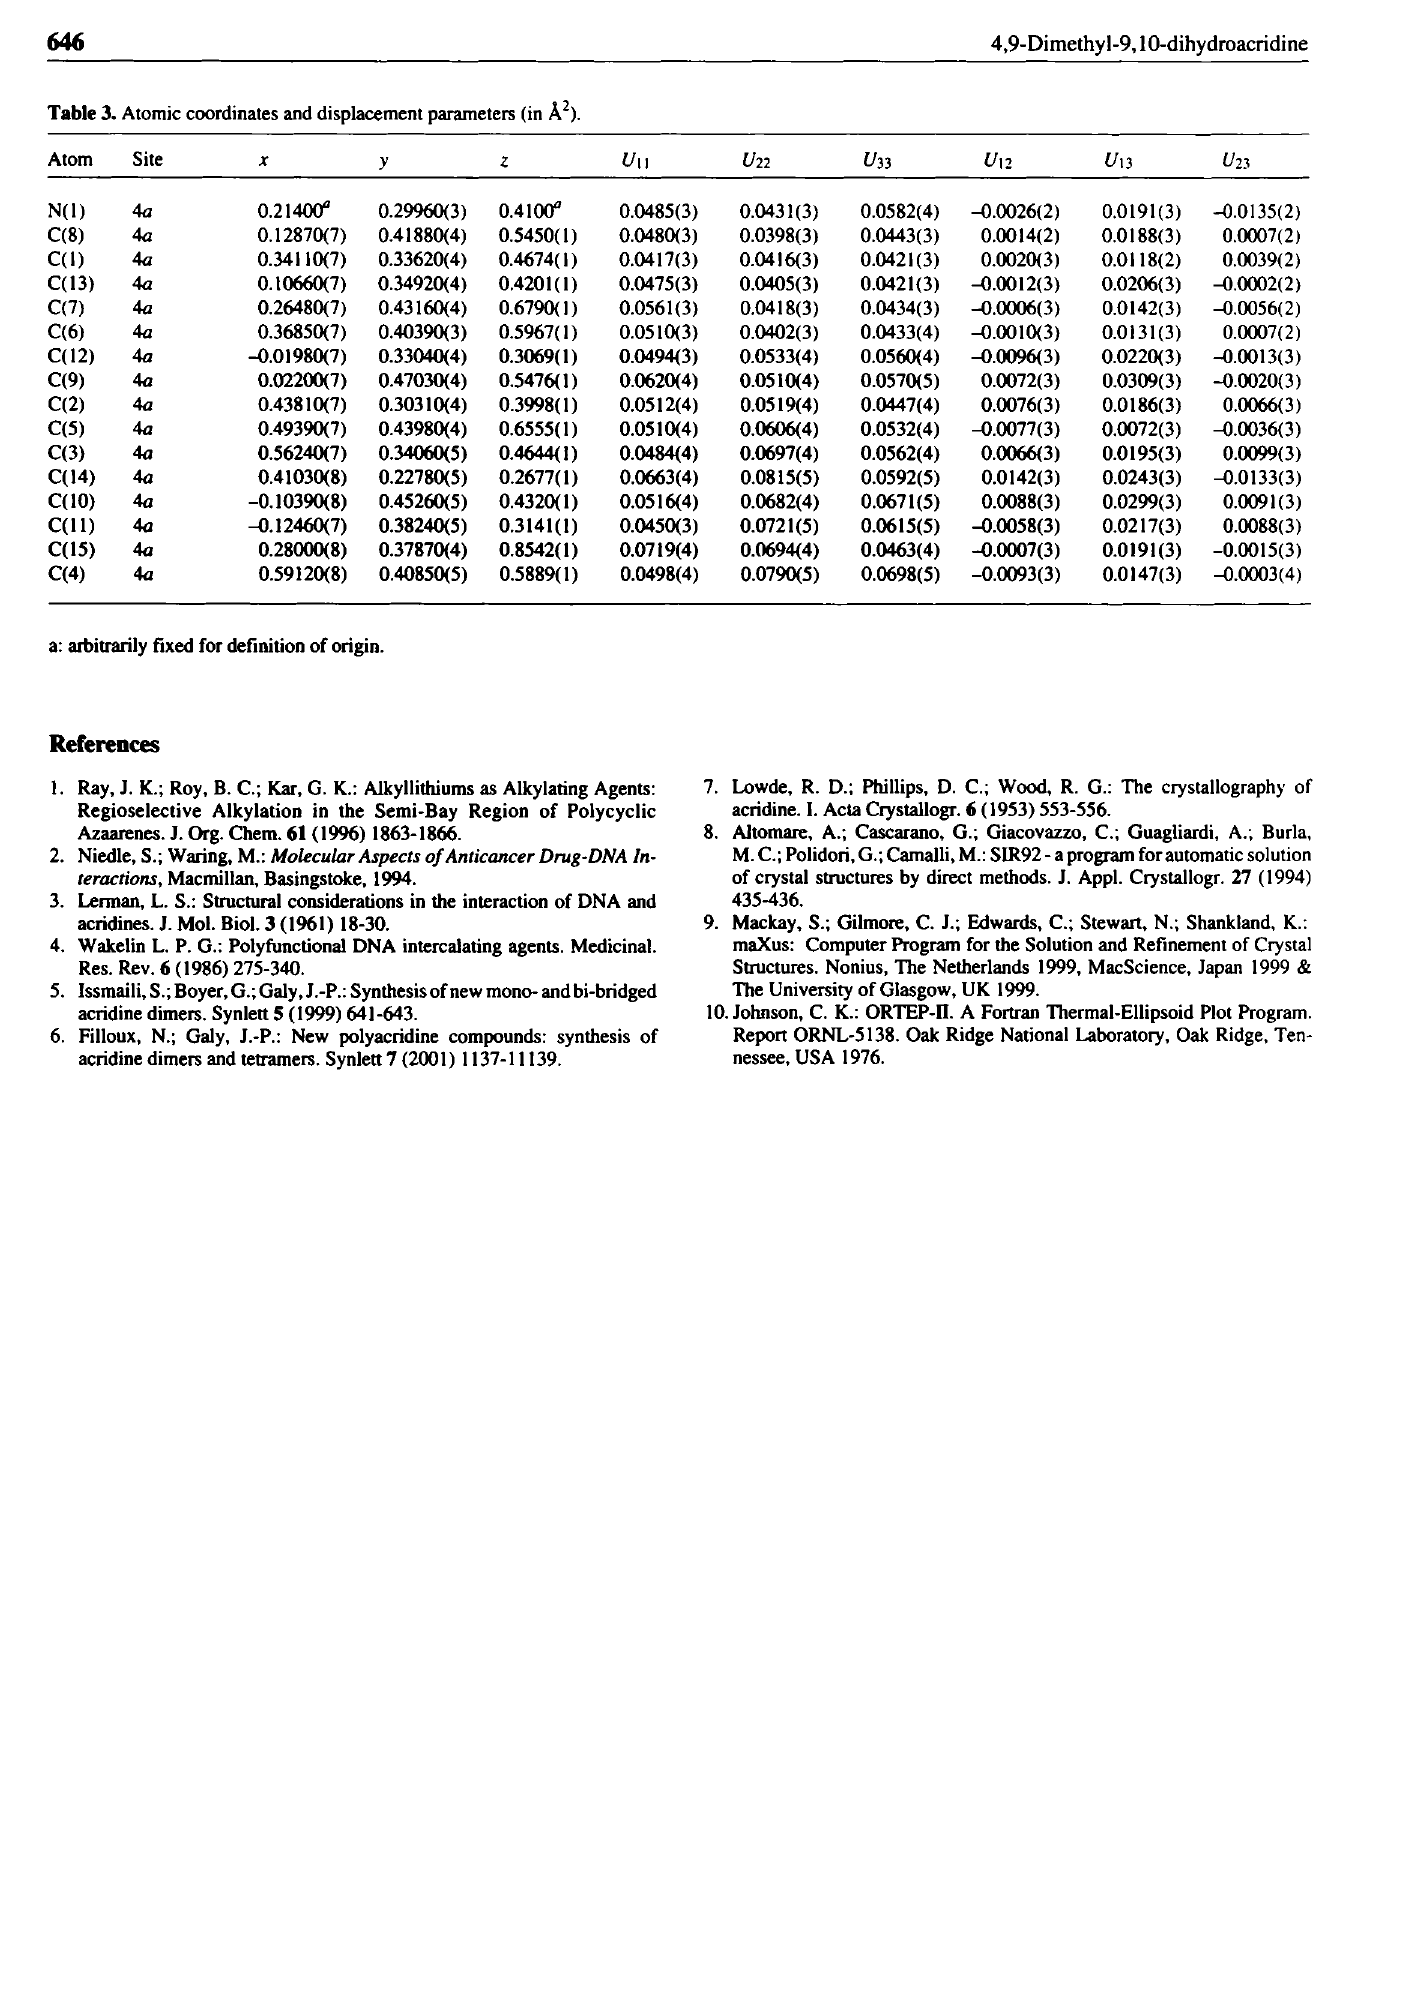
Table 3. Atomic coordinates and displacement parameters (in A 2